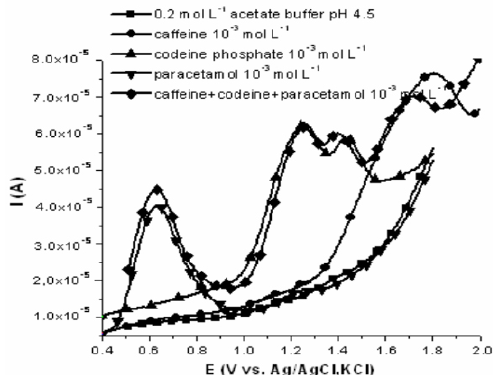
Figure 10. Square-wave voltammograms on electrochemically activated glassy carbon electrode for individual and simultaneous determination for 10 -3 mol L -1 caffeine, codeine phosphate and paracetamol solutions in